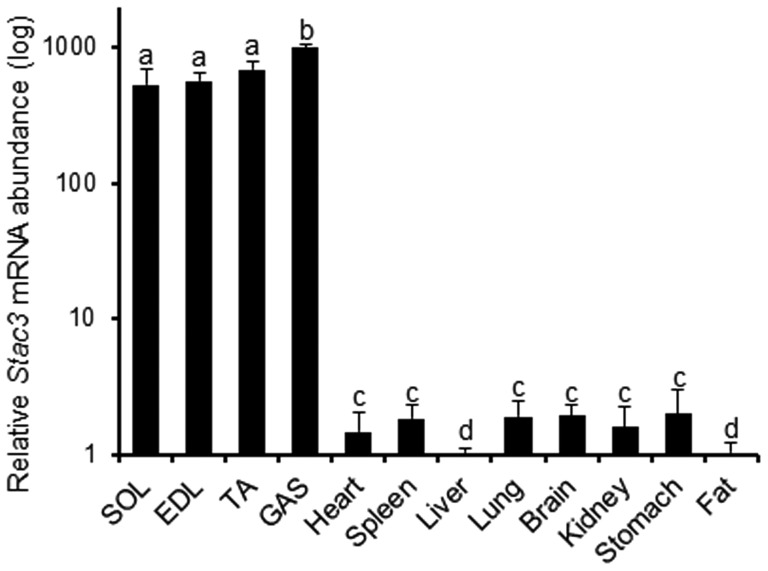
Skeletal muscle-predominant expression of Stac3 mRNA in mice.Tissues from three adult C57BL/6 male mice were analyzed by real-time RT-PCR. In this analysis, 18s rRNA was used as an internal control. Data are expressed as mean ± SEM (n = 3). Bars not sharing the same letter labels are different (P<0.05). The y-axis is displayed on a log10 scale. M: molecular ladder; SOL: soleus; EDL: extensor digitorum longus; TA: tibialis anterior; GAS: gastrocnemius.